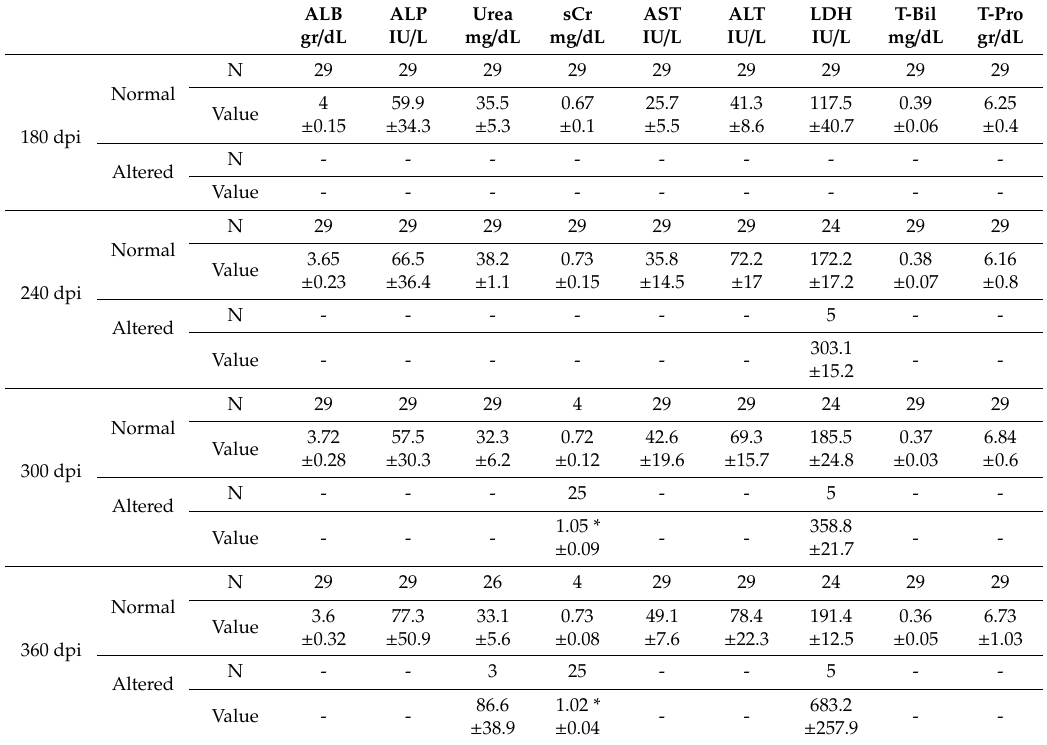
Table 1. Biochemical results at the sampling points. Number and mean ± SD values of animals with normal and altered values.